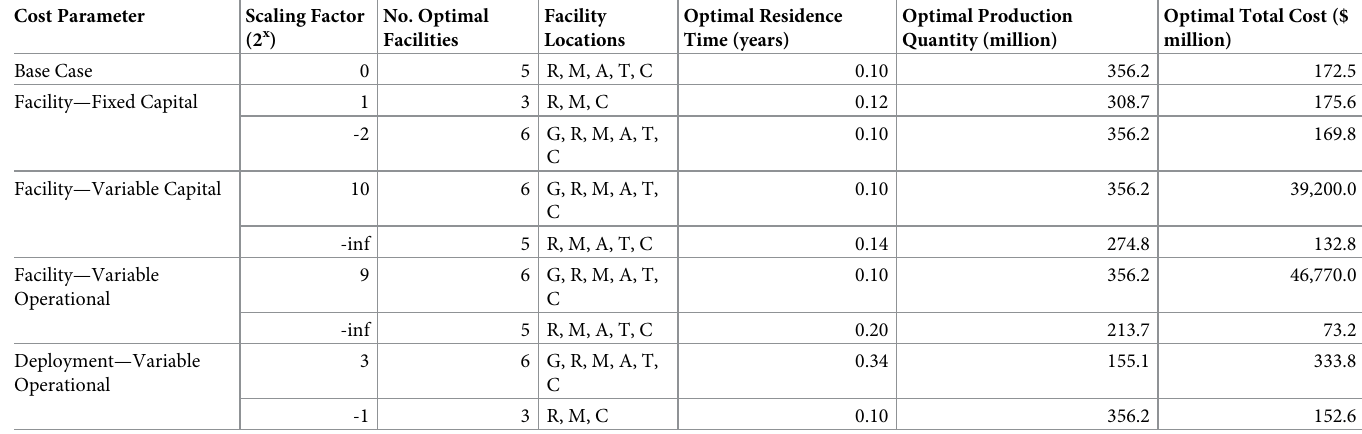
Table 2. Cost parameter sensitivity analysis. The base case scenario is listed, as well as solutions with cost parameter scaling variations resulting in optimal solutions with a different number of optimal facilities to the base case scenario. Facility locations are Bundaberg (B), Gladstone (G), Rockhampton (R), Mackay (M), Airlie Beach (A), Townsville (T), and Cairns